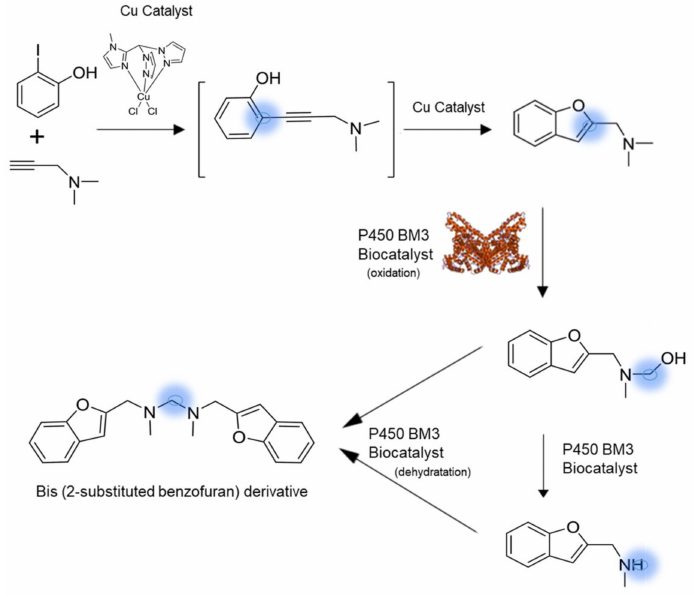
Figure 11. Chemoenzymatic cascade synthesis of a bis (2-substituted benzofuran) derivative [65]. In the first reaction step, a copper scorpionate catalyst (bis(pyrazol) (methyl imidazolyl)-methane copper (II) chloride complex) Cu scorpionate catalyst was used to synthesize a 2-substituted benzofuran from 2-iodophenol to perform a cascade Sonogashira coupling / cyclation reaction. In the next